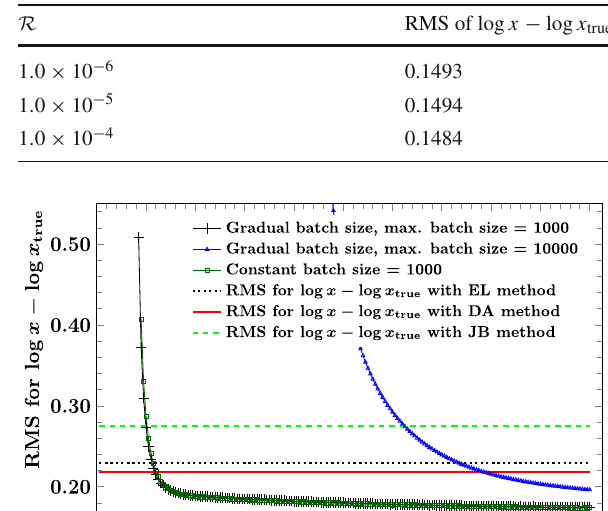
Table 2 Resolution of log x reconstruction after 200 epochs of training with different values of regularisation parameter R